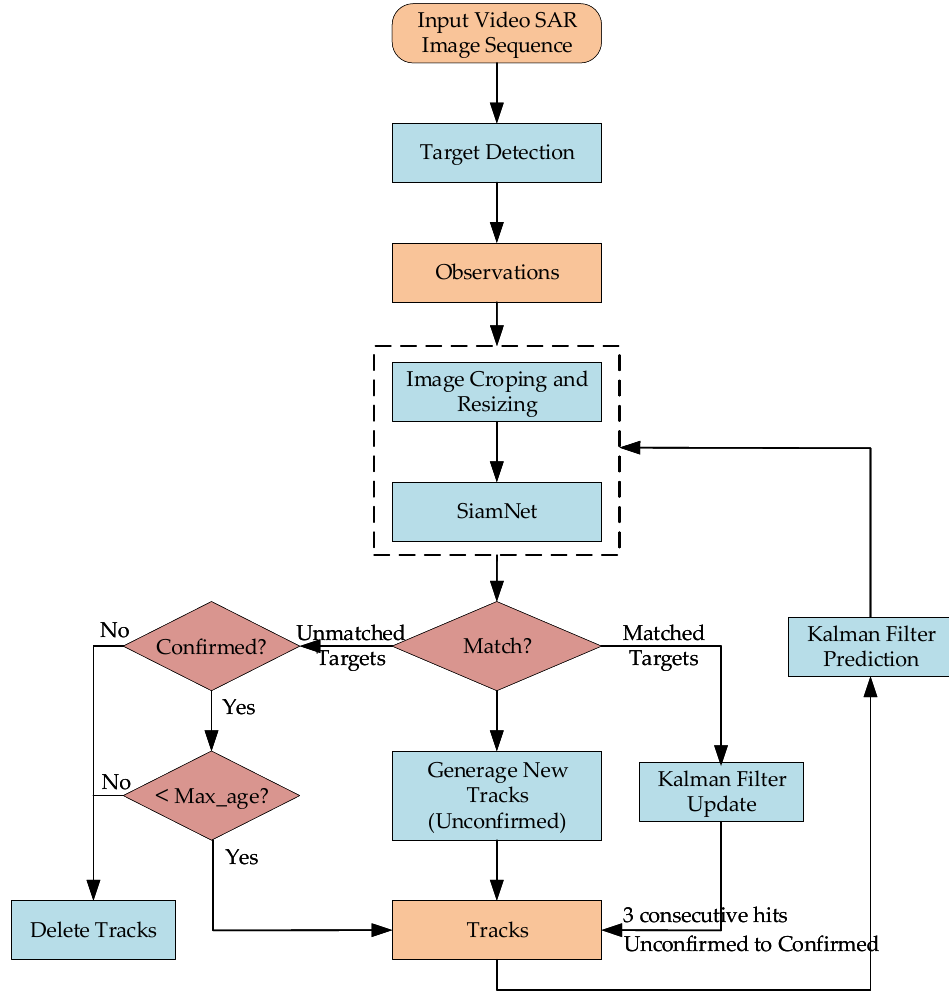
Figure 9. The whole process of Siam-sort for MTT in video SAR. Step 1 : Target detection using multi-scale